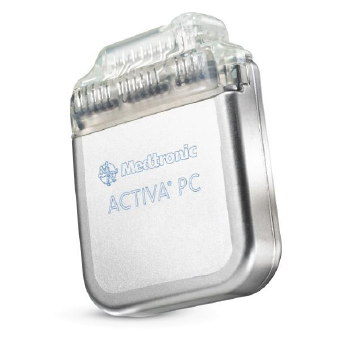
Figure 10. FDA approved deep-brain stimulation (DBS) system for epilepsy (Courtesy Food and Drug Administration (FDA)).